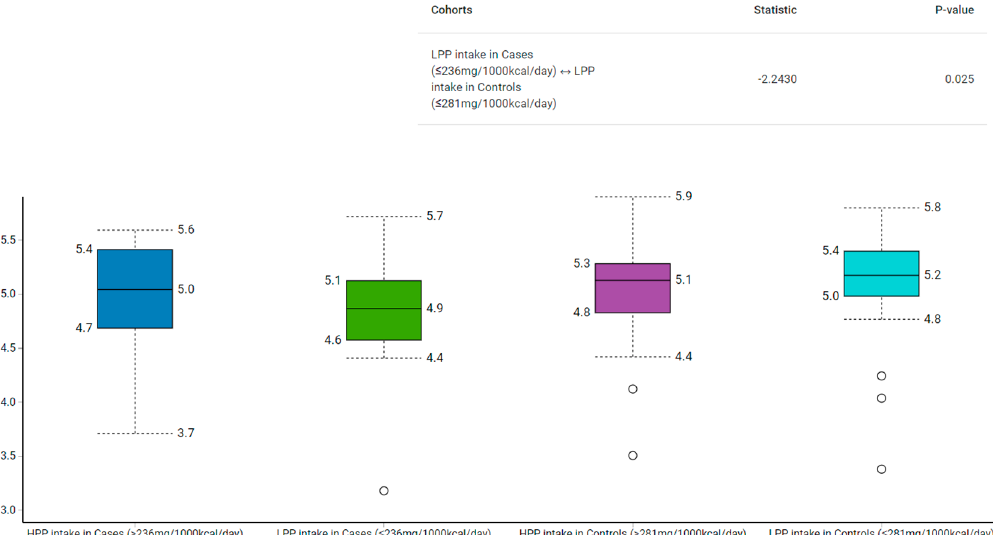
Figure 2. Comparison of gut microbiota α -diversity according to categories of polyphenol intake and relative to BMI using Shannon – Wiener Index. HPP, high polyphenols; LPP, low polyphenols.